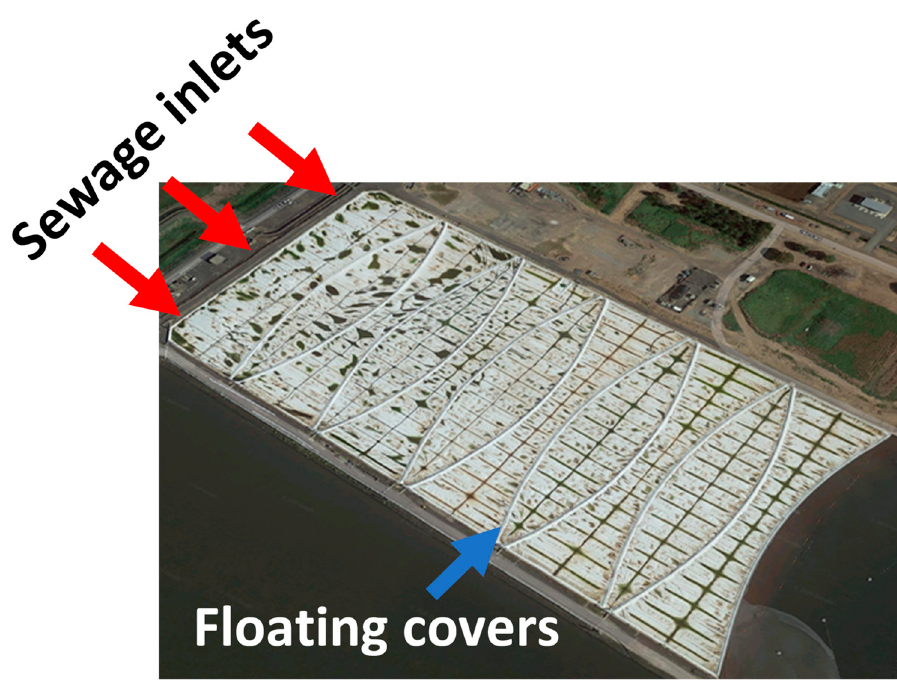
Figure 1. Aerial view of one of the two large (i.e., ~80,000 m 2 ) floating covers at WTP. UAV photogrammetry (using an optical vision camera integrated UAV) is a safe and time-efficient assessment technique [3] especially for monitoring large-scale engineering structures like floating covers at WTP. With sufficient overlapping of discrete aerial im- ages, photogrammetry can be used to establish and derive the geometric relationship be- tween the aerial images using commercialised software (i.e., Metashape or Pix4D). The common points between overlapping images can be used by a feature matching technique to generate an orthophoto, digital surface model (DSM), and digital elevation model (DEM) of each cover. The accuracy and reliability of UAV-aided photogrammetry have been validated [4] and its potential for remoting sensing applications is also discussed in the literature